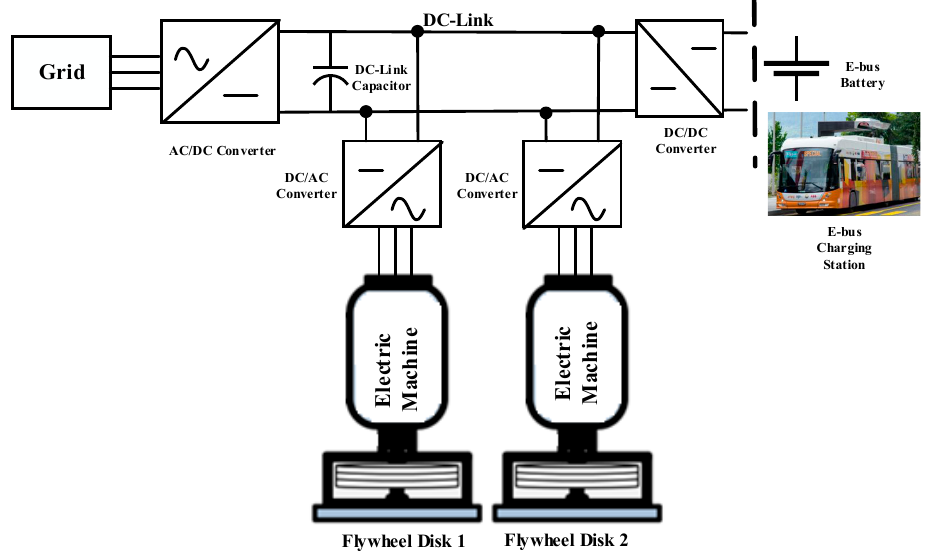
Figure 8. Proposed E-bus flash charging structure.